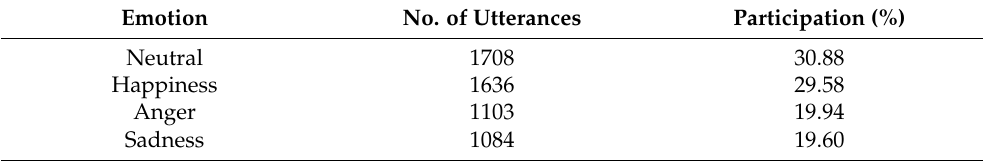
Table 2. The number of utterances in each class and their participation (%) in the IEMOCAP dataset. Emotion No. of Utterances